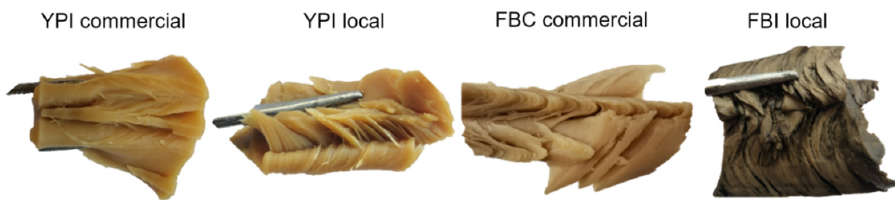
Figure 3. High-moisture meat analogues (HMMAs) produced from different pulse protein isolates/concentrate. YPI = yellow pea isolate, FBC = faba bean concentrate, FBI = faba bean isolate.